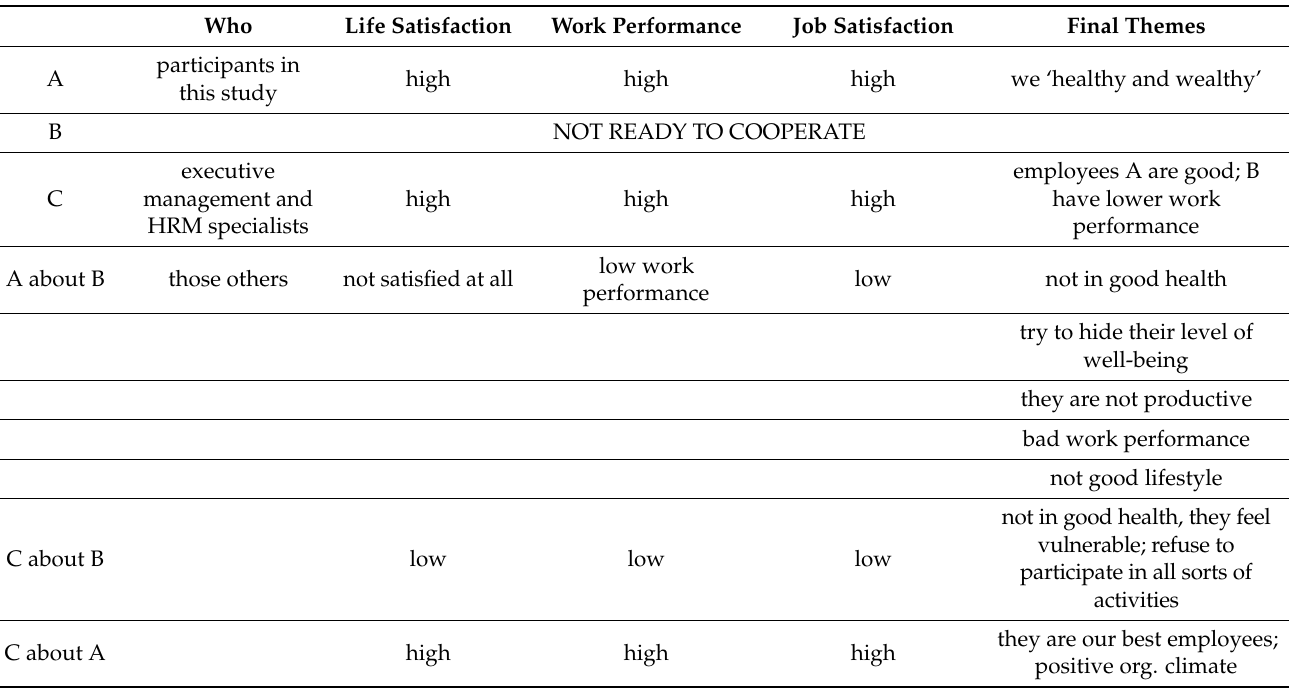
Table 4. Results of systematic observations and one-to-one